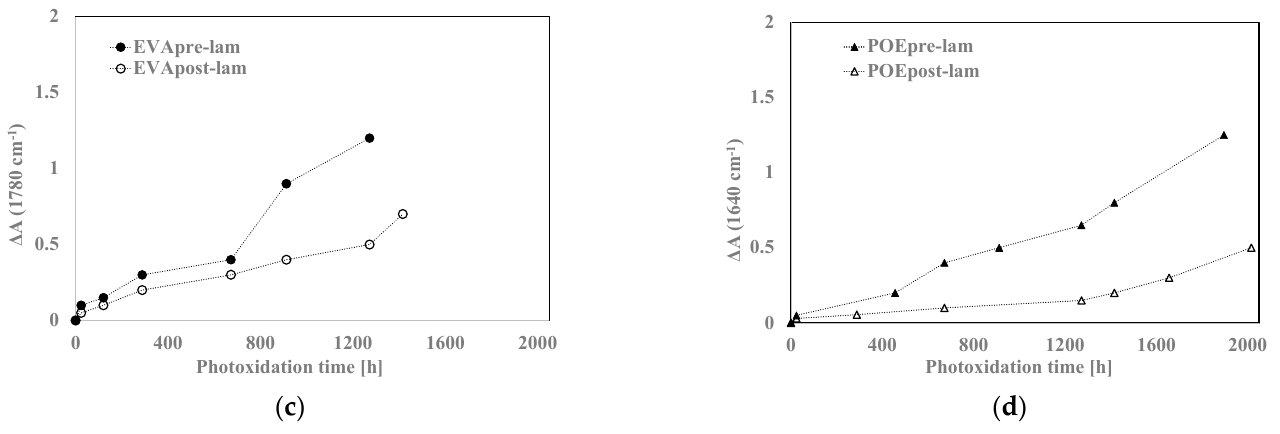
Figure 8. Variation of absorbance ( a , b ) at 3200–3600 cm − 1 for EVA and POE samples, respectively, ( c ) at 1780 cm − 1 for EVA and ( d ) at 1640 cm − 1 for POE.